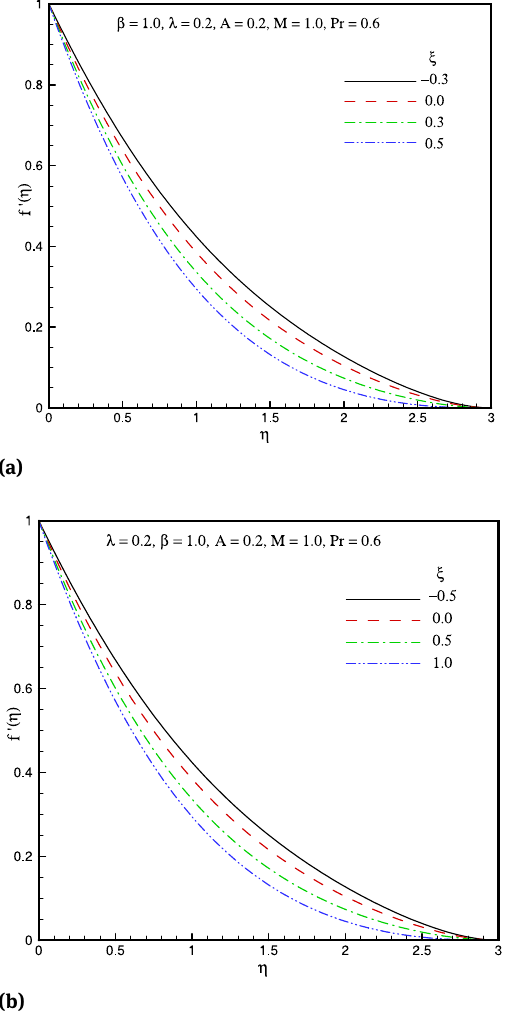
Figure 5: Simulated velocity and temperature graphs for various values of convection parameter